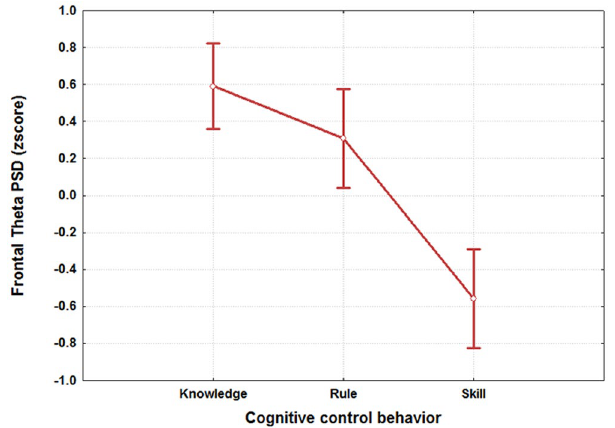
Figure 4. The figure reports the results of the ANOVA analysis on the frontal theta PSD with the factor “SRK” of 3 levels (Skill, Rule and Knowledge). The results showed that such brain feature could be used as SRK discriminant brain feature, as its PSD values were significantly different (p = 0.000001) between the S, R and K levels.